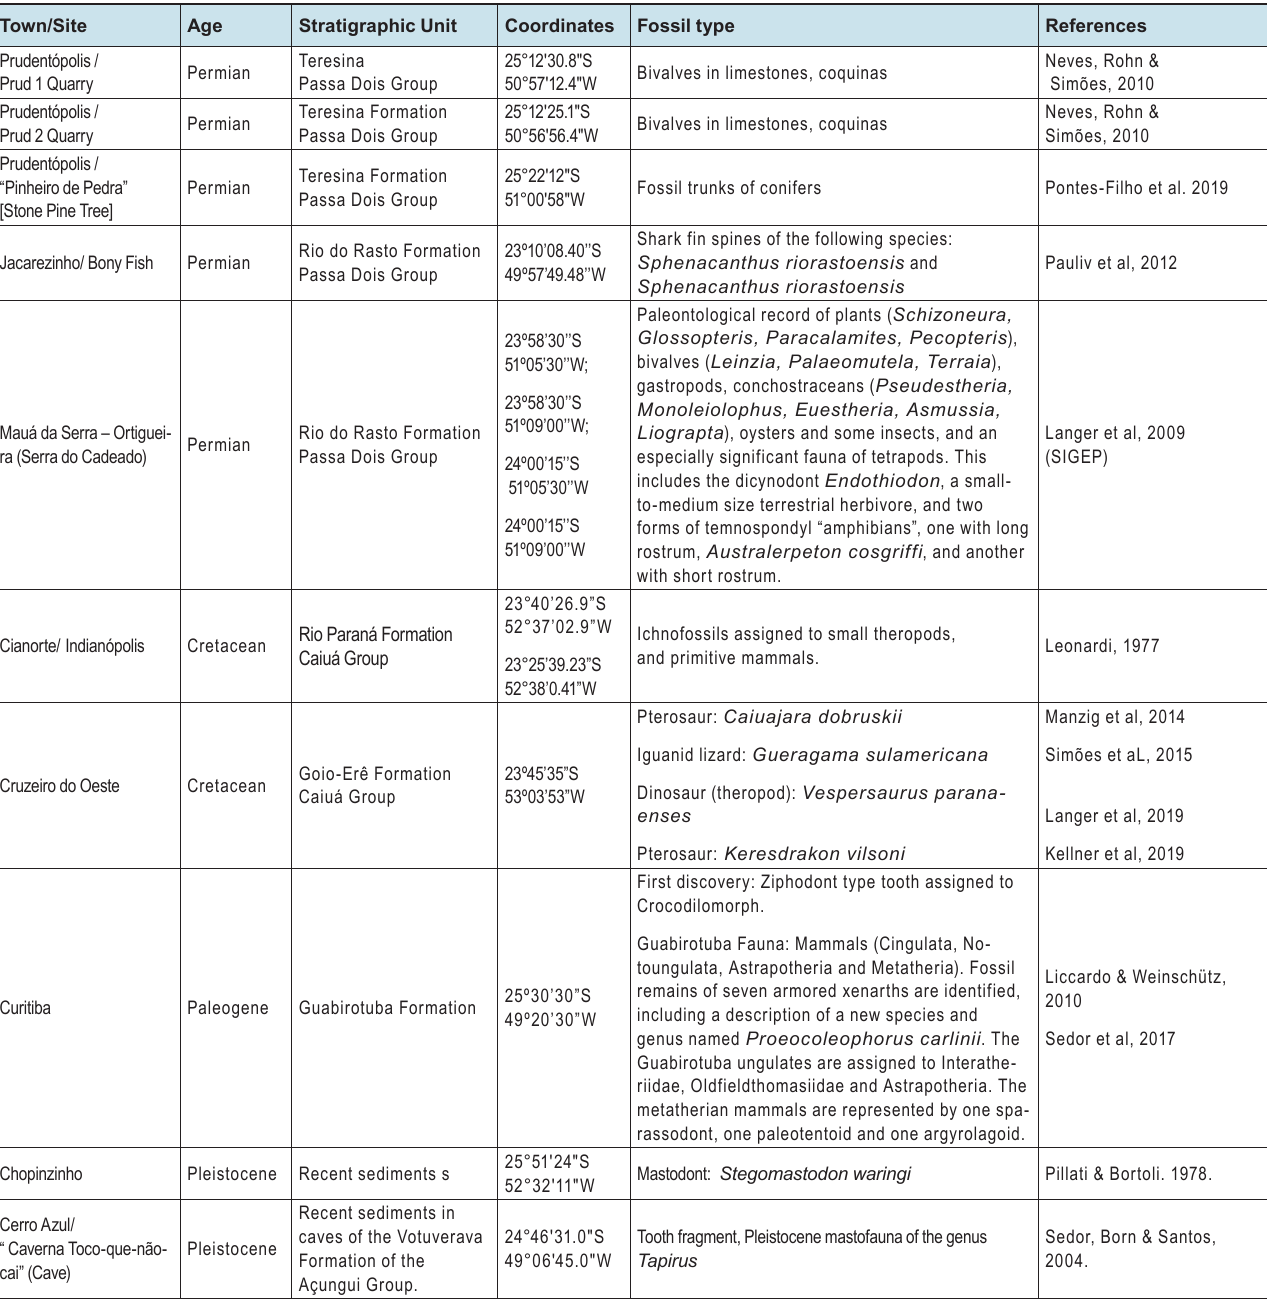
Table 1: Main paleontological sites in Paraná State Town/Site